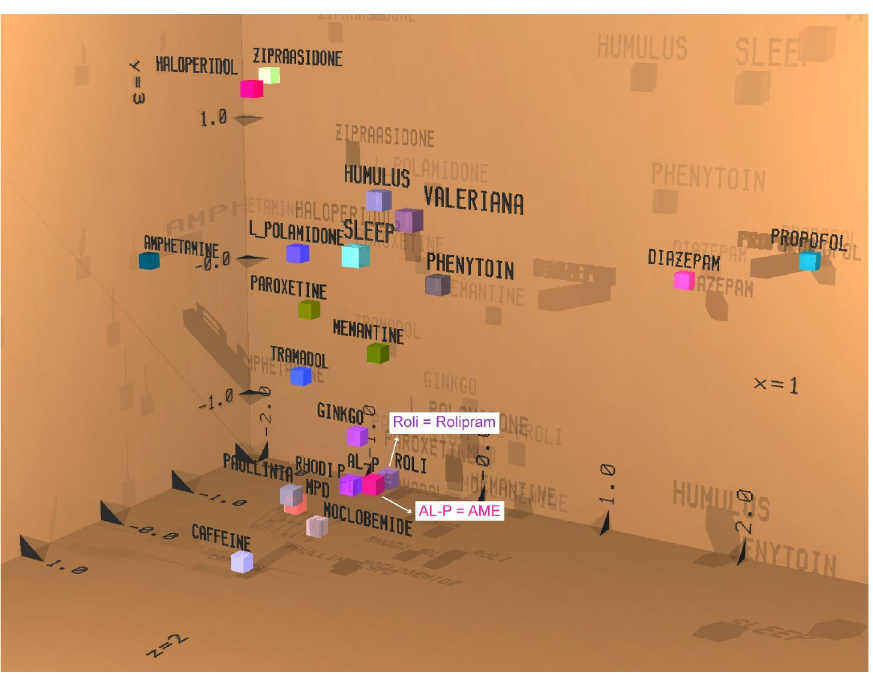
Fig 3. Discriminant analysis of electropharmacograms. Comparison of the electropharmacogram of the ethanolic extract of Aframomum melegueta seeds (AME; 100.0 mg/kg) administered orally. Synthetic drugs were given by intraperitoneal injection. The patterns of the reference drugs providing similar spectral frequency changes for similar clinical indications according to the results of the first three discriminant functions are positioned in close proximity (see x, y, and z coordinates). A high similarity with respect to space and colour signalizes similar net effects with respect to clinical indication. Data are from the first recording period after administration.